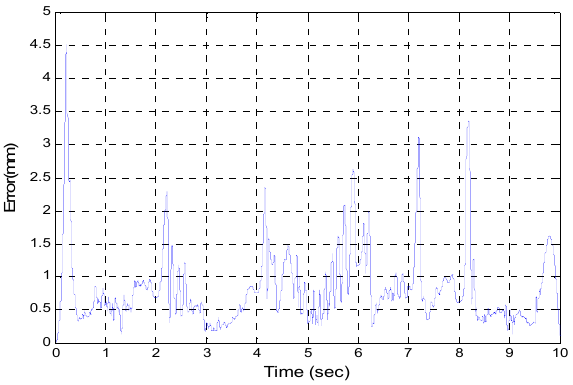
Figure 20. Calculated end-effector trajectory tracking error.